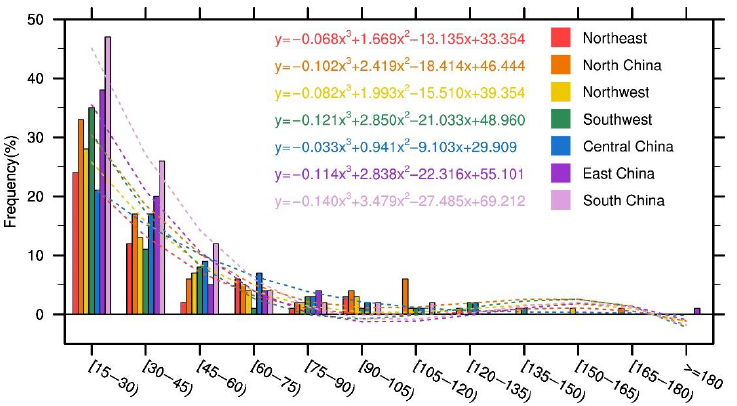
Figure 5. Frequency distribution of regional drought processes in China from 1961 to